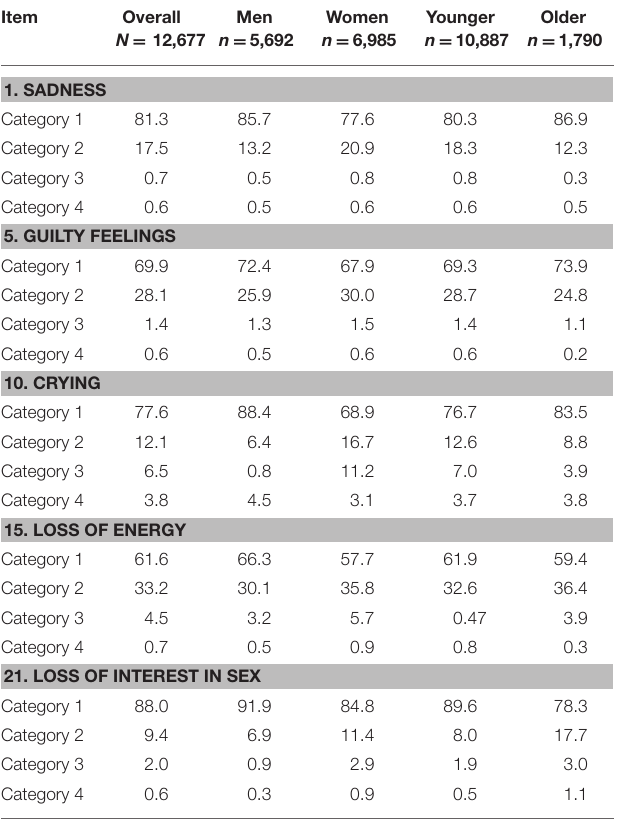
TABLE 2 | BDI-II response proportion (%) for responses categories on selected items. Table 3 shows discrimination ( a ) and severity threshold ( b i ) estimates of depressive symptoms for all 21